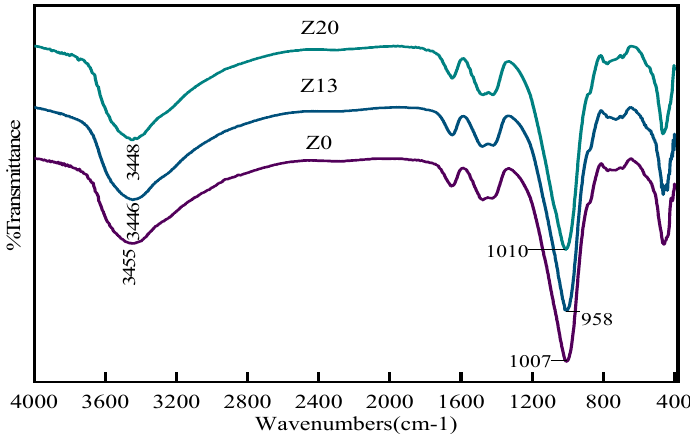
Figure 11. FTIR spectra of geopolymers with different mixing ratios.